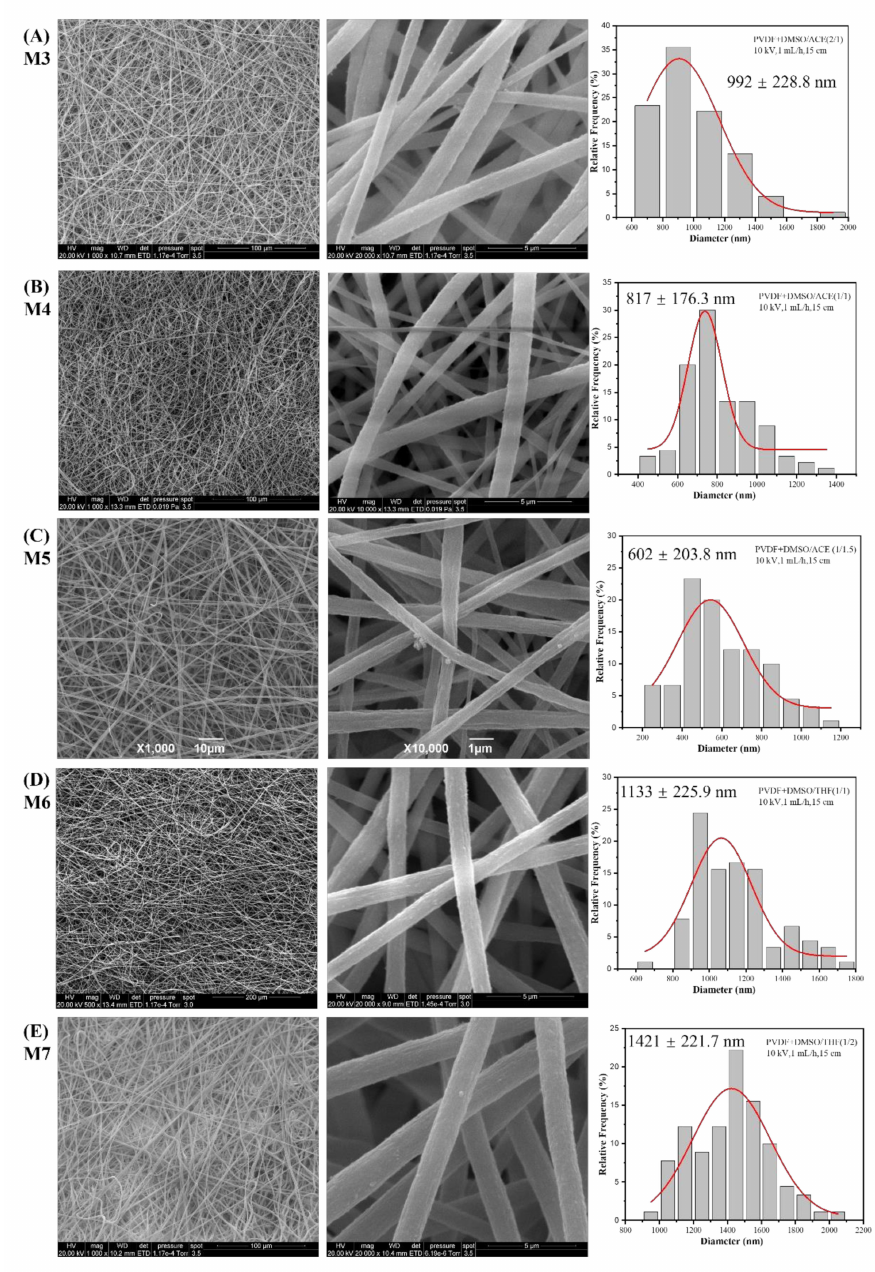
Figure 4. SEM images at two magnifications and the diameter histogram of PVDF nanofibrous membrane ( A ) M3 (using DMSO/ACE (2/1)), ( B ) M4 (using DMSO/ACE (1/1)), ( C ) M5 (using DMSO/ACE (2/3)), ( D ) M6 (using DMSO/THF (1/1)), and ( E ) M7 (using DMSO/THF